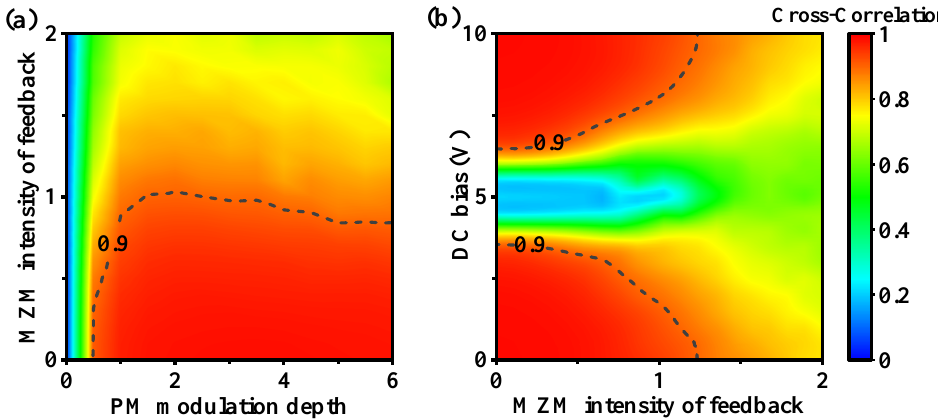
Figure 5. ( a ) Cross-correlation versus modulation depth of PM and feedback intensity of MZM; ( b ) cross-correlation versus DC bias and feedback intensity of